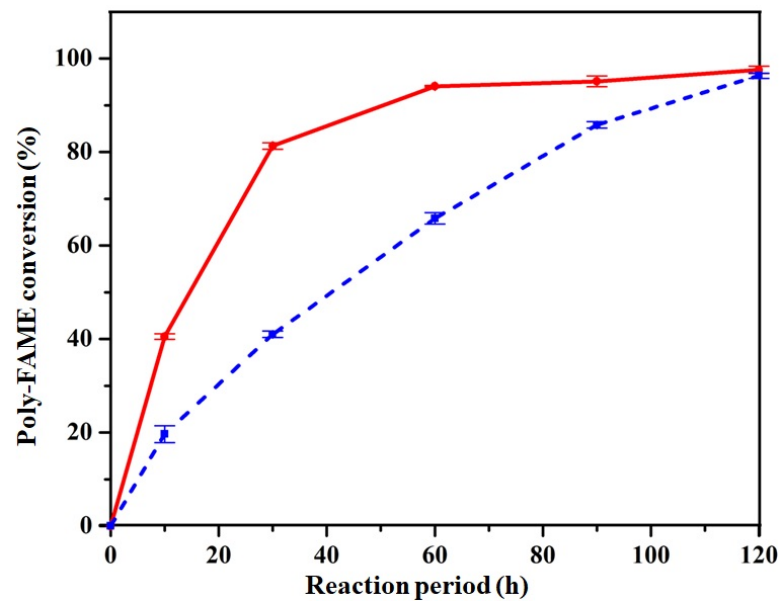
Figure 9. Poly-FAME conversion at various reaction times of Pd/NPC-H (solid line) and Pd/NPC-K (dashed line) catalysts.